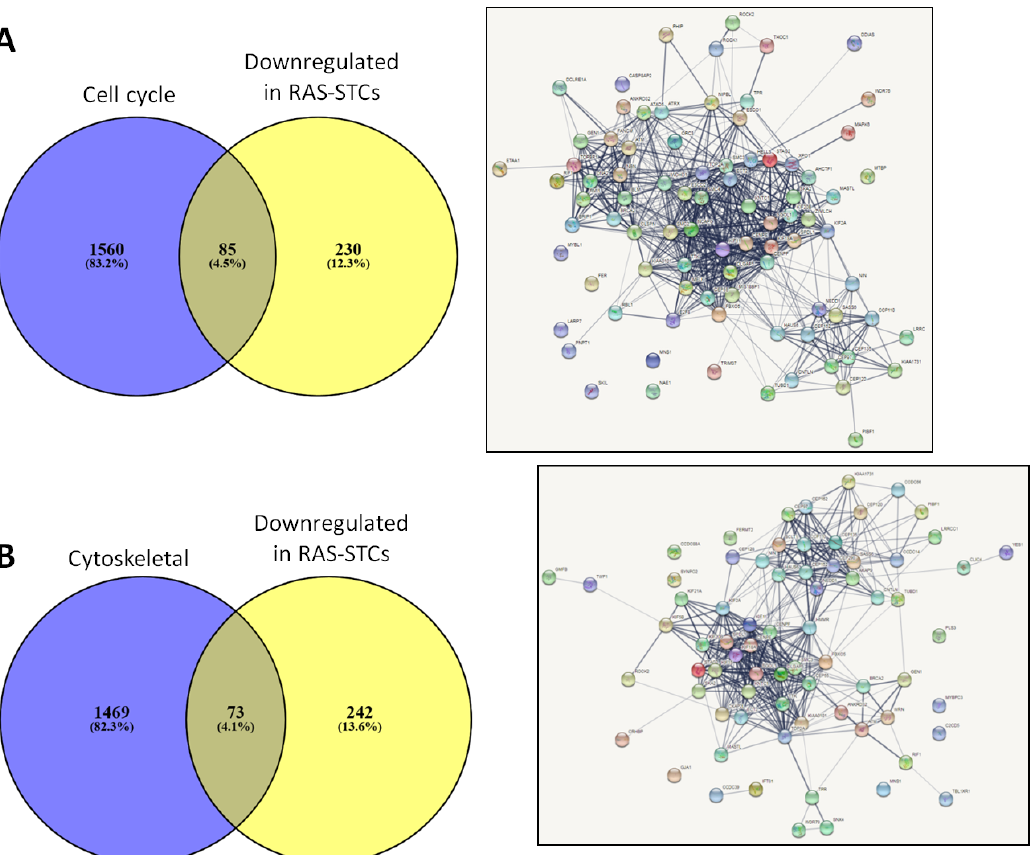
Figure 7. Venn diagram analysis (Venny 2.1) indicated that 85 cell cycle ( A ) and 73 cytoskeletal ( B ) genes were downregulated in RAS-STCs. Search Tool for the Retrieval of Interacting Genes (STRING) was used to predict associations between these genes.